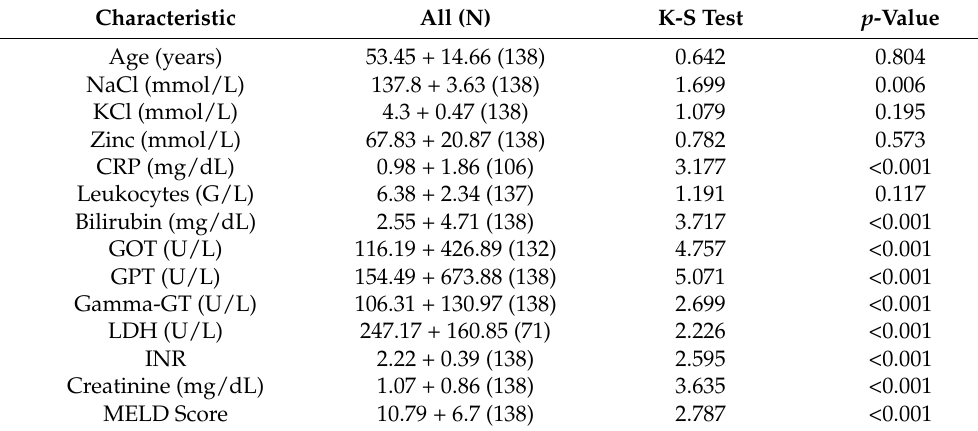
Table 1. Normality test of laboratory